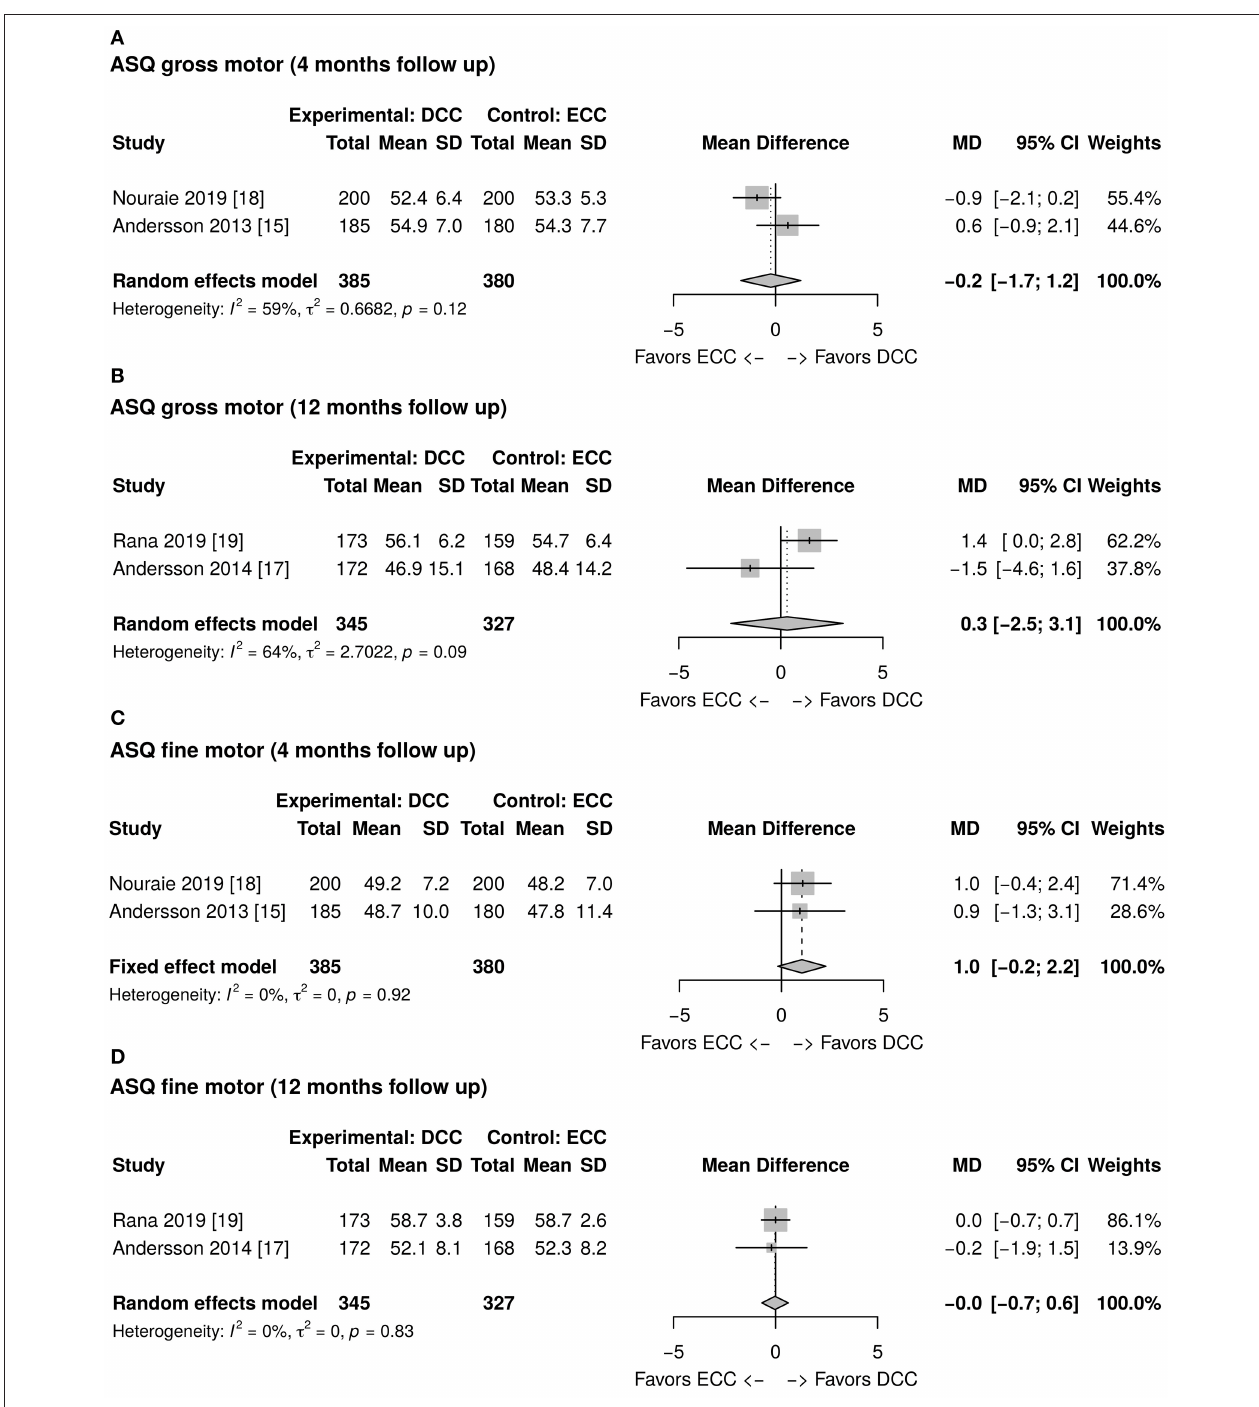
FIGURE 3 | (A) Forest plot showing mean difference of the Ages and Stages Questionnaire (ASQ) gross motor domain score at 4 months follow up between delayed cord clamping (DCC) and early cord clamping (ECC) groups. (B) Forest plot showing mean difference of the ASQ gross motor domain score at 12 months follow up between DCC and ECC groups. (C) Forest plot showing mean difference of the ASQ fine motor domain score at 4 months follow up between DCC and ECC groups. (D) Forest plot showing mean difference of the ASQ fine motor domain score at 12 months follow up between DCC and ECC groups.